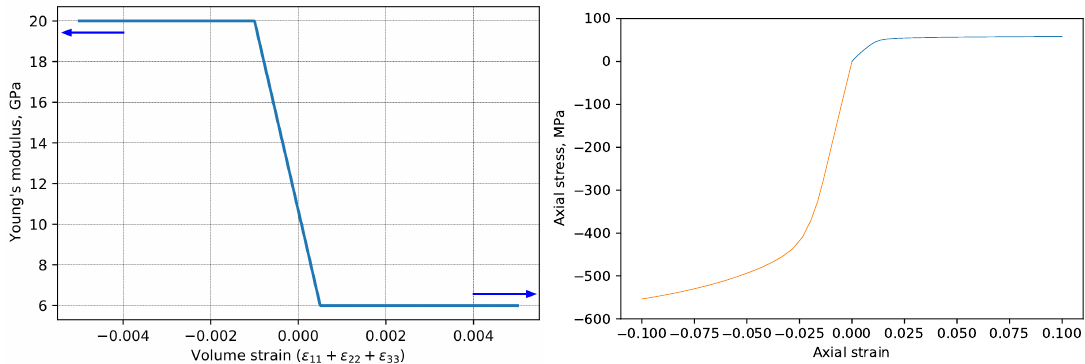
Figure 8. Model of graphite material. ( Left ): Young’s modulus of graphite as a function of volume strain. ( Right ): stress–strain curve for graphite under uniaxial tension and compression.